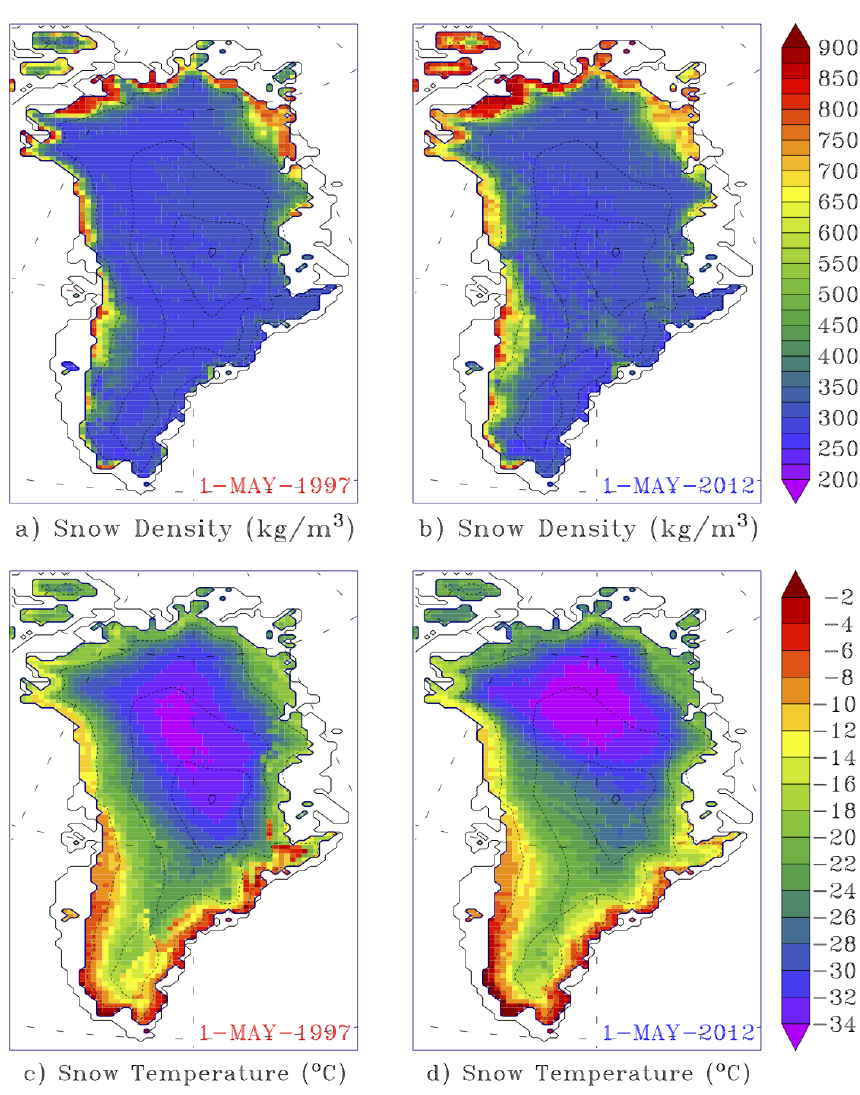
Fig. 10. Mean density (kgm − 3 , top figures) and mean snow temperature ( ◦ C, bottom figures) within the first 2m of snow simulated by MAR on 1 May 1997 (a) , (c) , and 1 May 2012 (b) , (d) .